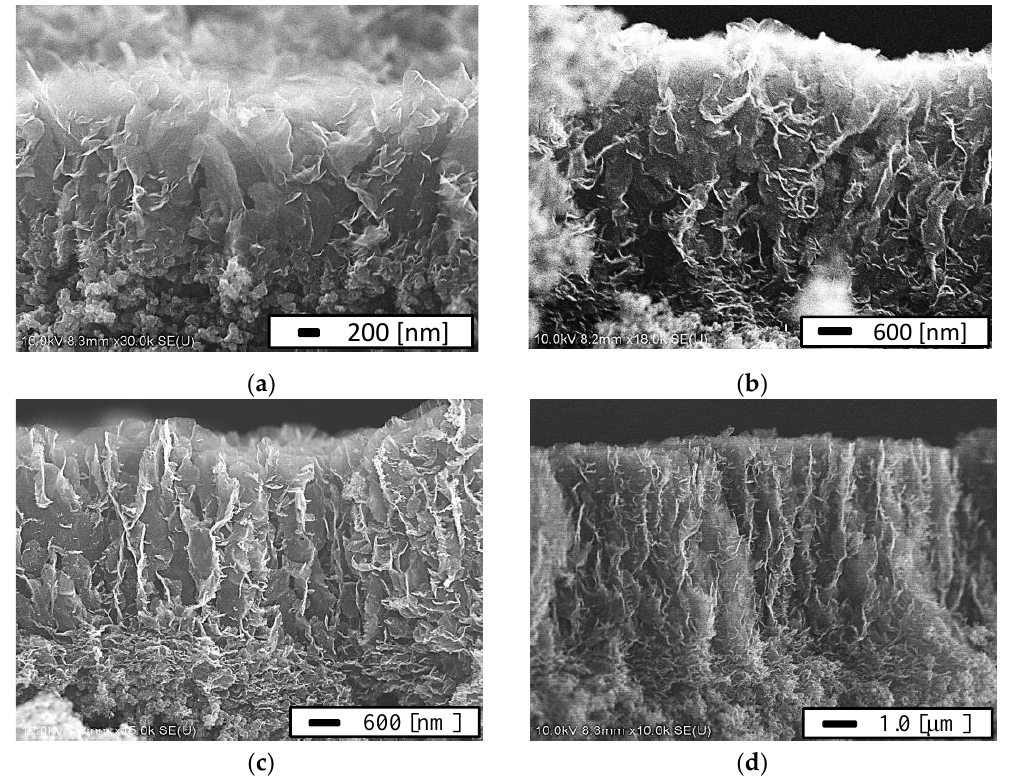
Figure 4. Cross-sectional view of the SEM images of the CNWs at a growth time of ( a ) 2 h, ( b ) 3 h, ( c ) 3.5 h, and ( d ) 4 h.